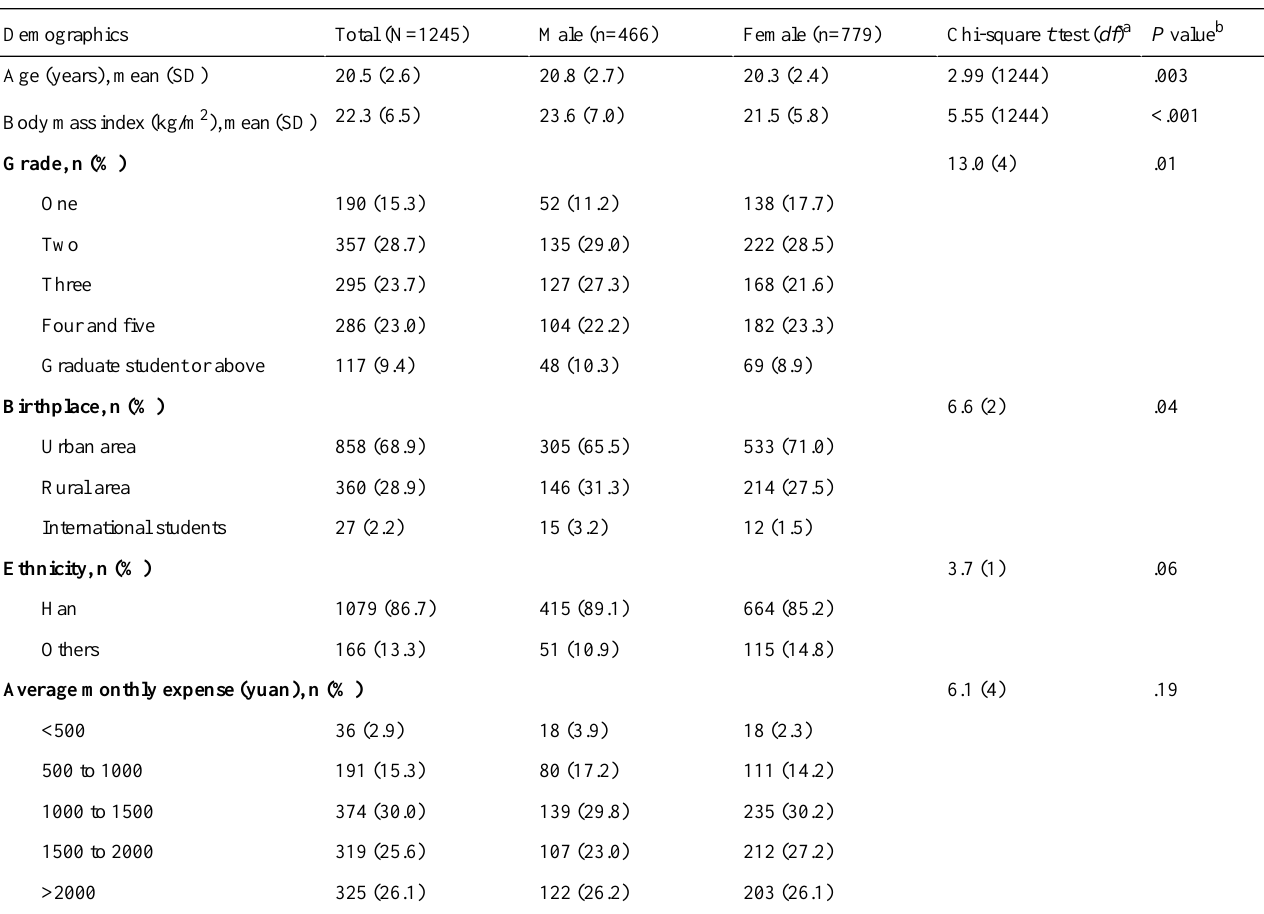
Table 1. Participants’demographic information.